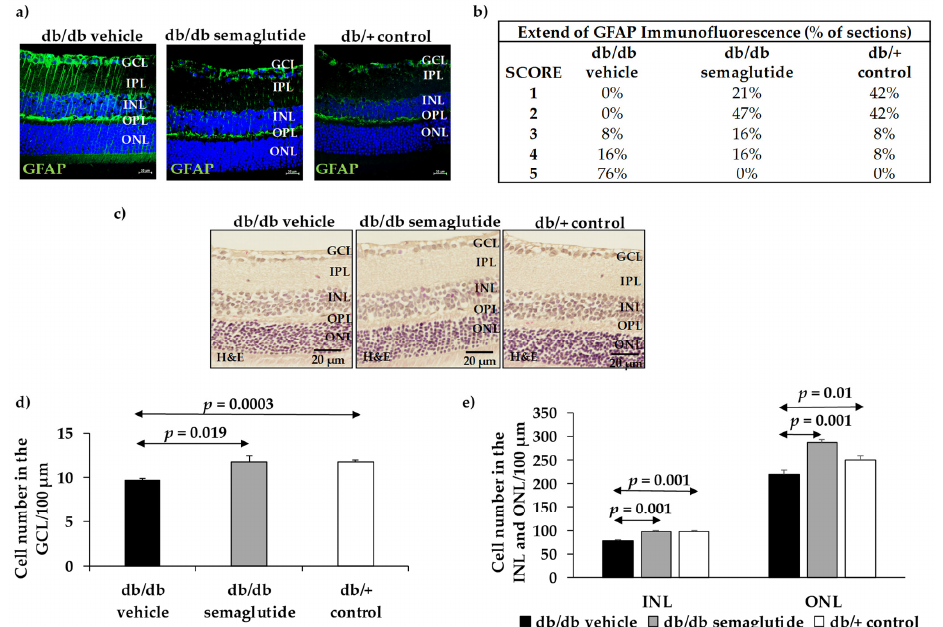
Figure 2. Effect of semaglutide eye drops on glial activation and apoptosis. ( a ) Comparison of GFAP immunoreactivity (green) in the retina among representative samples from a diabetic mouse treated with vehicle, a diabetic mouse treated with semaglutide, and a non-diabetic mouse. Nuclei were labeled with Hoechst (blue). ONL: outer nuclear layer; OPL: outer plexiform layer; INL: inner nuclear layer; IPL: inner plexiform layer; GCL: ganglion cell layer. Scale bars, 20 μm. ( b ) Quantification of glial activation based on the extent of GFAP staining. ( c ) Comparison of hematoxylin/eosin (HE) retinas among representative samples from diabetic mice treated with vehicle, semaglutide and from a non-diabetic mouse. ( d ) Quantification of the number of cells in GCL. ( e ) Quantification of the number of cells in the INL and